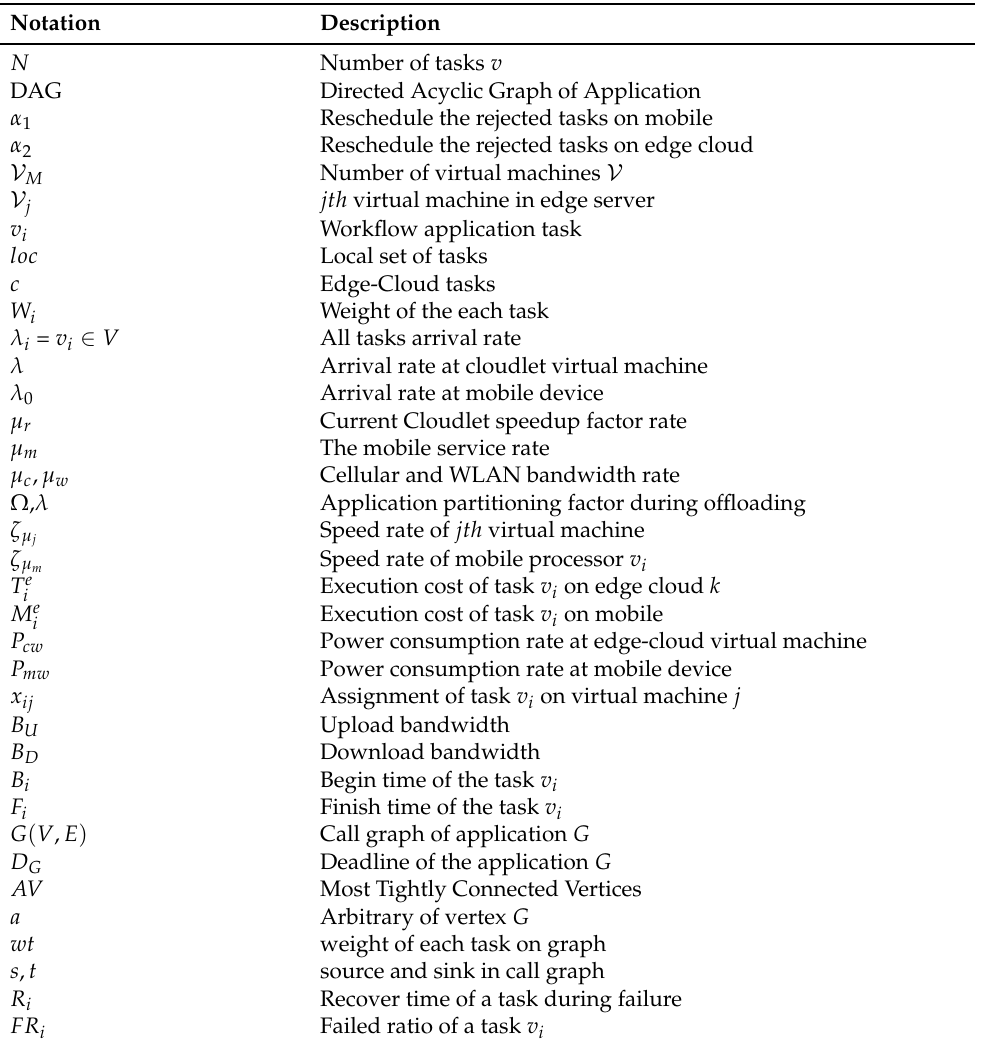
Table 1. Mathematical